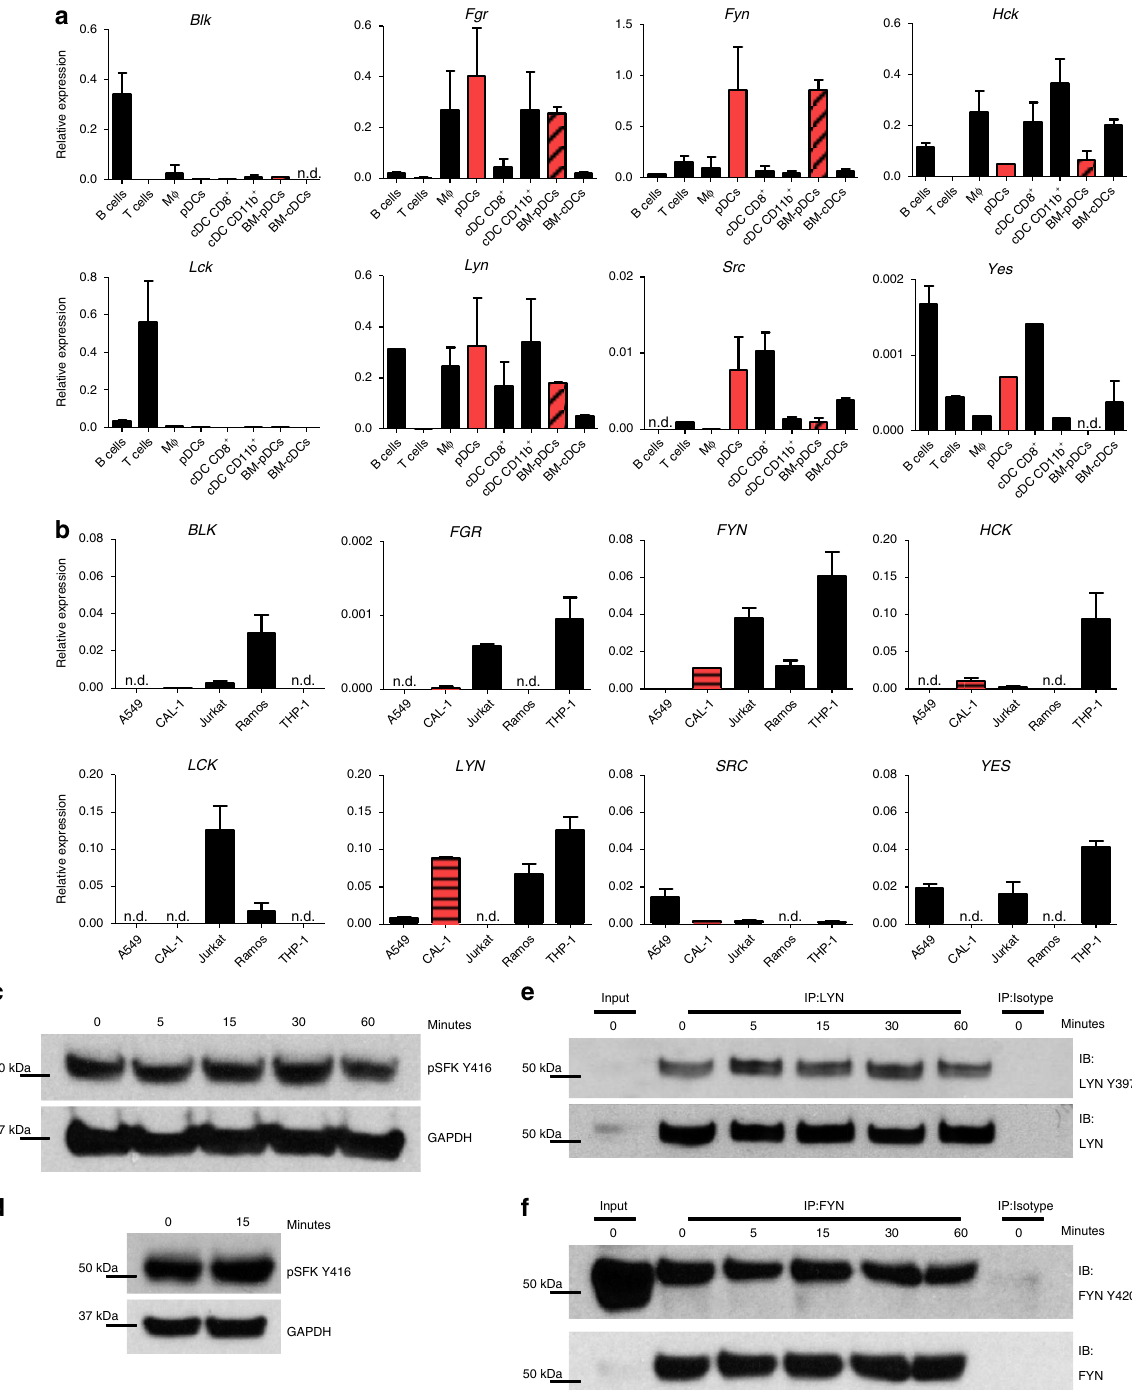
Figure 1 | pDCs have constitutive LYN and FYN expression and activating phosphorylation. The expression of SFK mRNAs in mouse immune subsets ( a ) and human cell lines ( b ) were assessed by qPCR and normalized against the expression of GAPDH. In a , the immune subsets were FACS purified from freshly isolated spleen or from BM cells cultivated for 8 days in the presence of Flt3L. In b , cells from human cell lines were collected before reaching confluency and then total RNAs were extracted. Splenic pDCs are highlighted in solid red; BM-derived pDCs are highlighted in black-diagonal striped red; CAL-1 are highlighted in black-horizontal striped red. Graph bars represent mean ± s.d. of two independent experiments. A549: lung epithelial cell line; CAL-1: human pDC cell line; Jurkat: T-cell line; Ramos: B-cell line; THP-1: monocyte cell line. ( c , d ) CAL-1 cells ( c ) or human primary pDCs ( d ) were stimulated with R848 for the indicated time periods (minutes) and SFK activating tyrosine phosphorylation (Y416) and GAPDH were assessed by immunoblot. ( e , f ) CAL-1 cells were stimulated with R848 for the indicated time periods (minutes) and protein immunoprecipitation was performed using anti-LYN ( e ) or anti-FYN ( f ) antibodies or isotype control antibody. Levels of LYN or FYN activating tyrosine phosphorylation and total LYN or FYN were assessed by immunoblot. Results are representative of two independent experiments ( c – e , f ) or three individual donors ( d